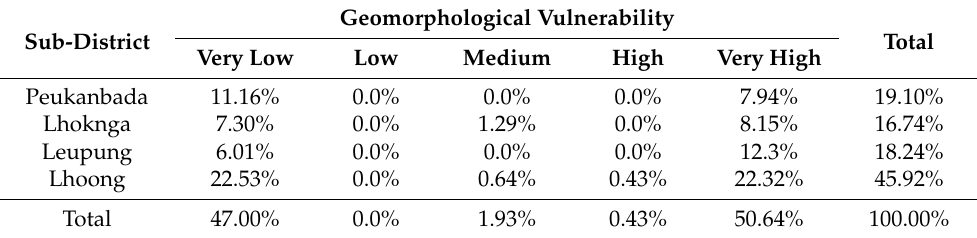
Table 4. Percentage of coastal vulnerability in terms of coastal